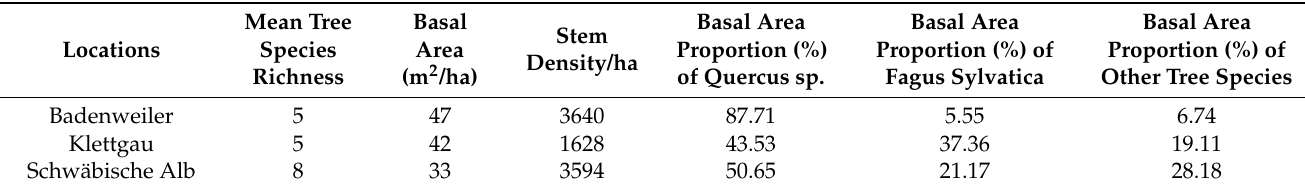
Table 3. Tree species richness, basal area, stem density, and basal area proportion of oak, beech, and other tree species in study